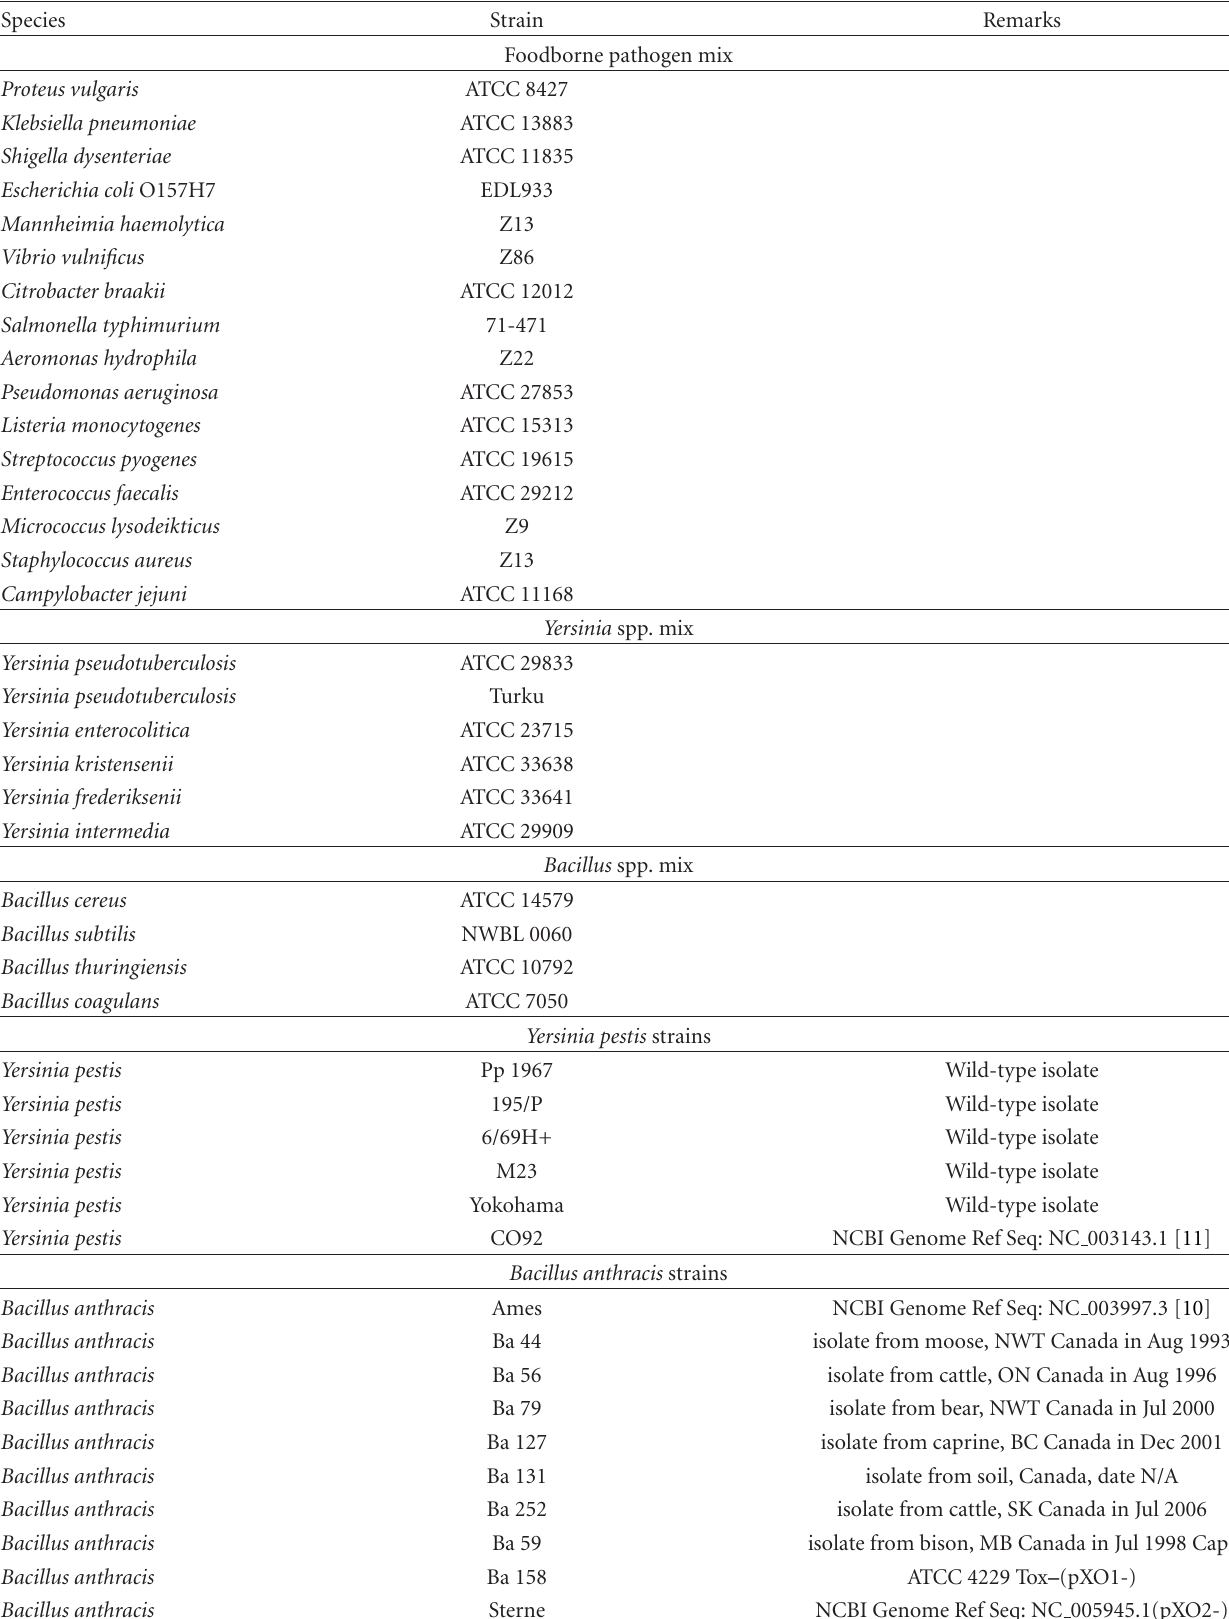
Table 1: Strains used in this